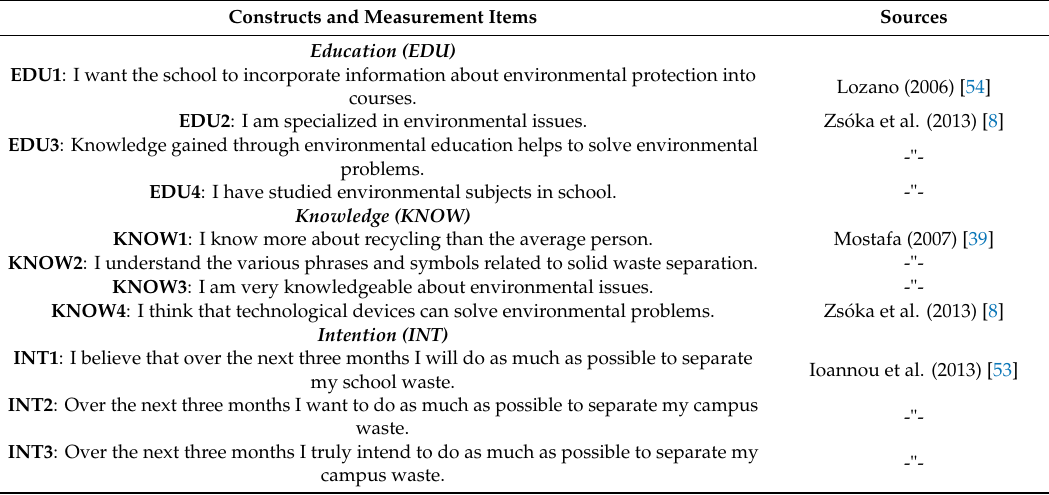
Constructs and Measurement